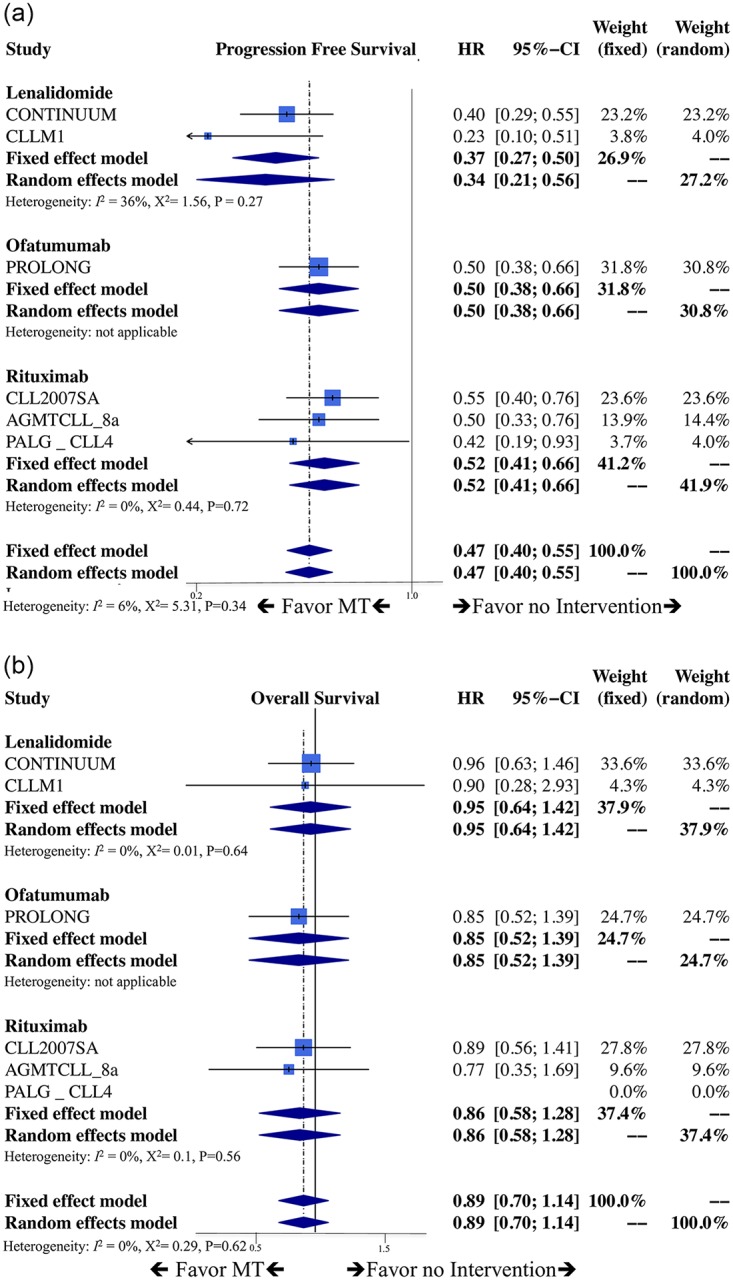
Pair-wise meta-analysis.a. Forest plot of progression-free survival. HR: hazard ratio, CI: confidence interval, MT: maintenance therapy, OBS: no intervention. b. Forest plot of overall survival. HR: hazard ratio, CI: confidence interval, MT: maintenance therapy, OBS: no intervention.